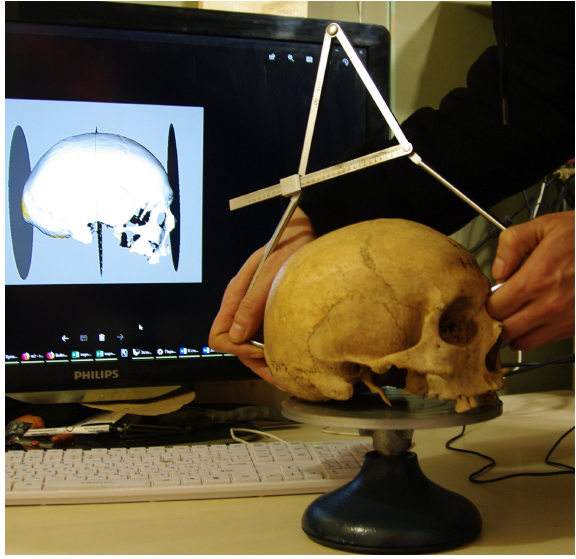
Figure 5. Anthropological parameters measuring